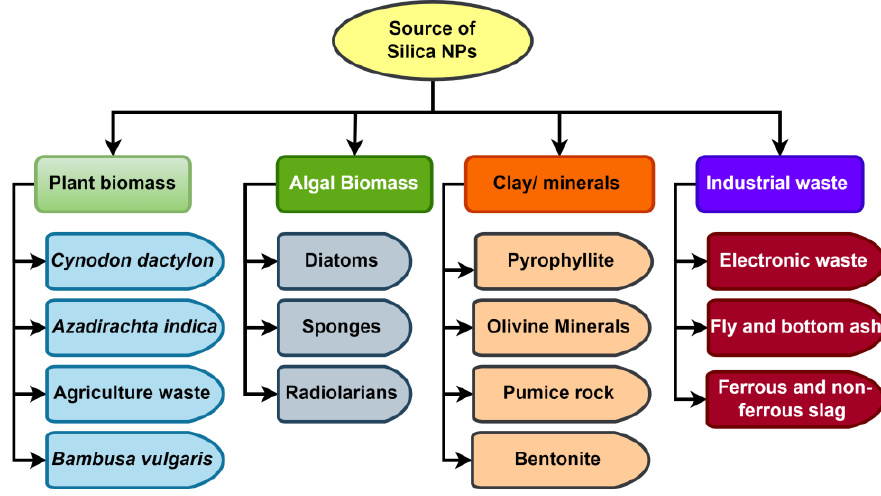
Figure 4. Different raw materials for commercial production of silica